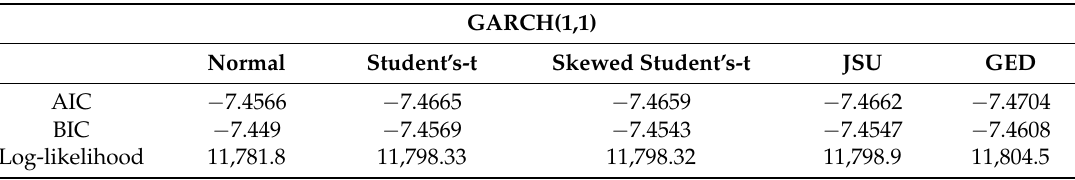
Table 1. Daily variance forecast: GARCH(1,1)